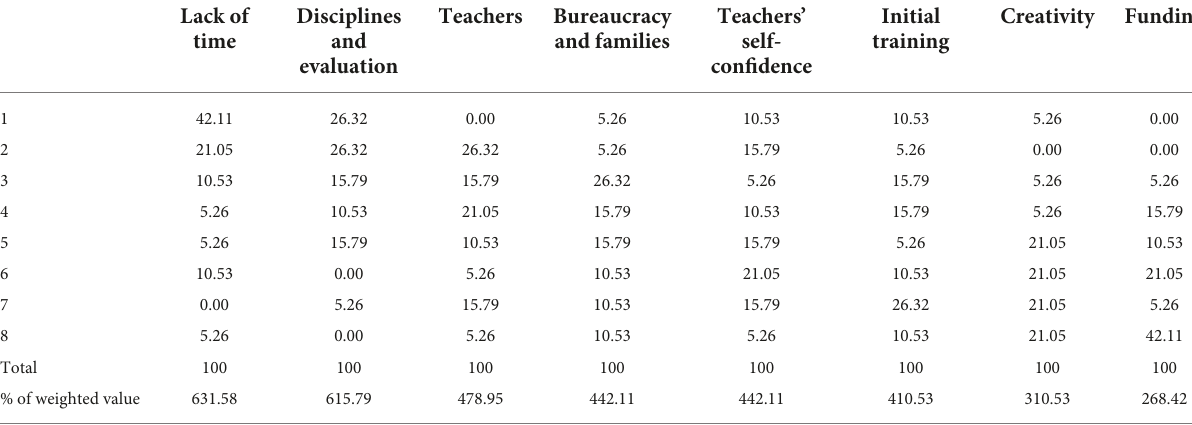
TABLE 11 Opinions on resistance to educational innovation, from highest to lowest